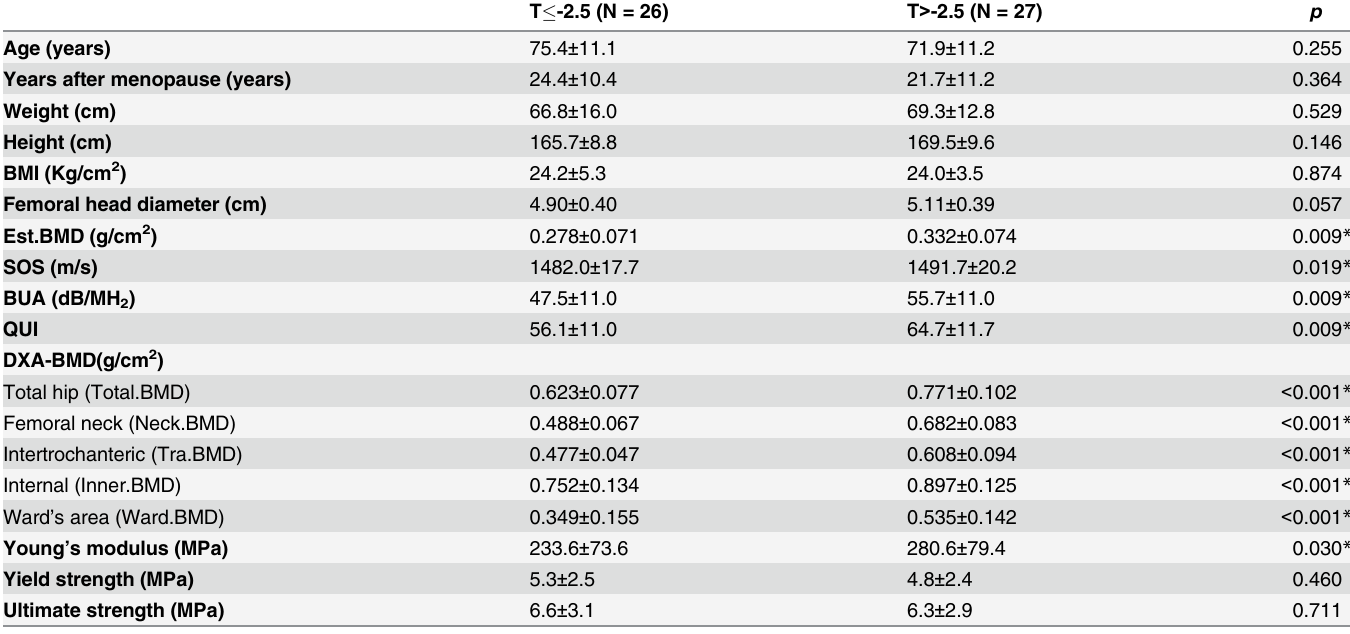
Table 1. Background data of study subjects (n = 53; mean ± SD).